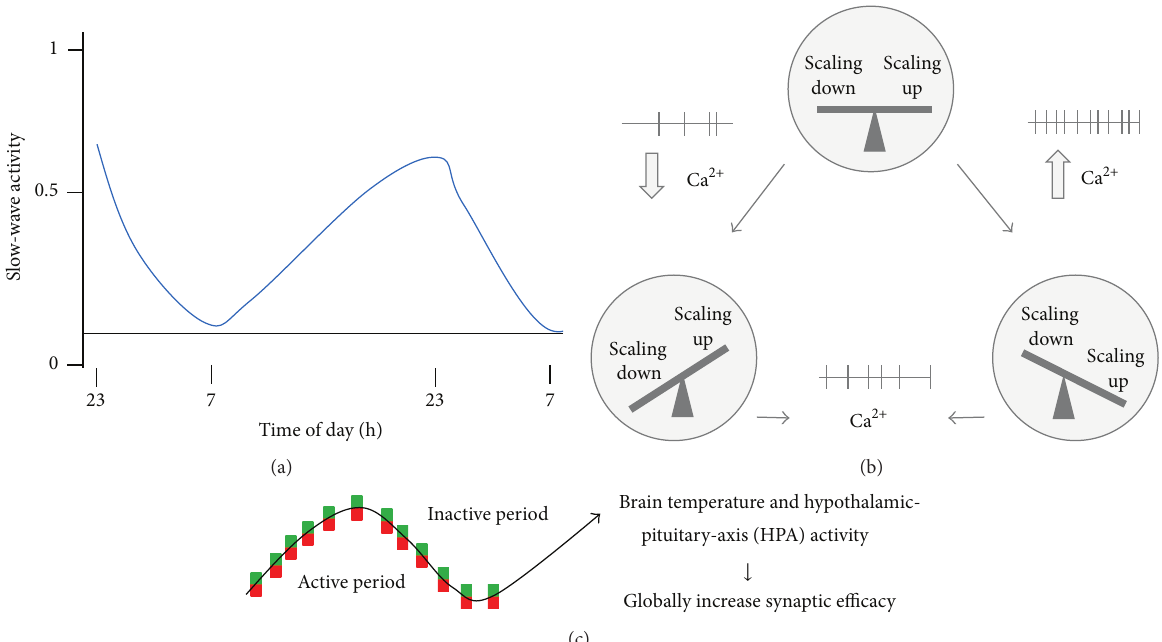
Figure 1: (a) Nonrapid eye movement (NREM) sleep slow-wave activity (SWA) increases with time spent awake and decreases during sleep modified from [18]. (b) Calcium-dependent pathways regulate both scaling up and scaling down, to maintain a balance between excitation and inhibition modified from [19]. (c) Circadian modulation of synaptic plasticity modified from